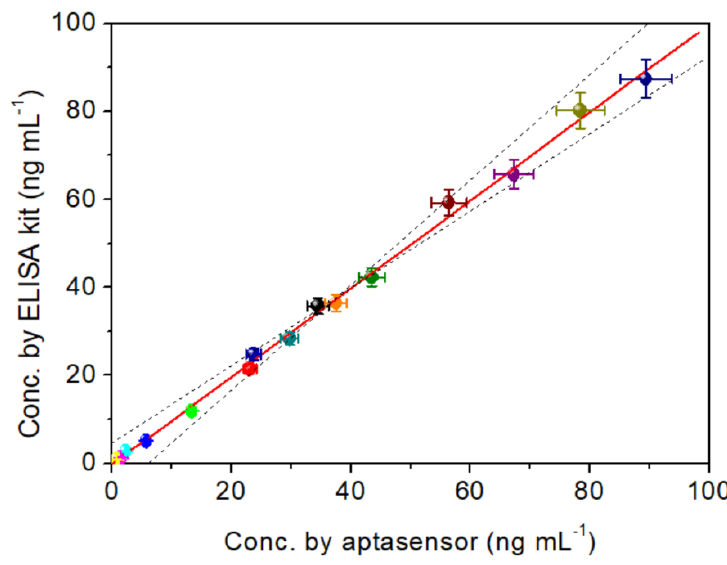
Figure 7. Comparison of the results of sample detection between spectrometric aptasensor and human CEA ELISA kit. (Note that each data point represents the average value obtained from three measurements. The error bars represent the 95% confidence interval of the mean for y-axis concen- trations.)